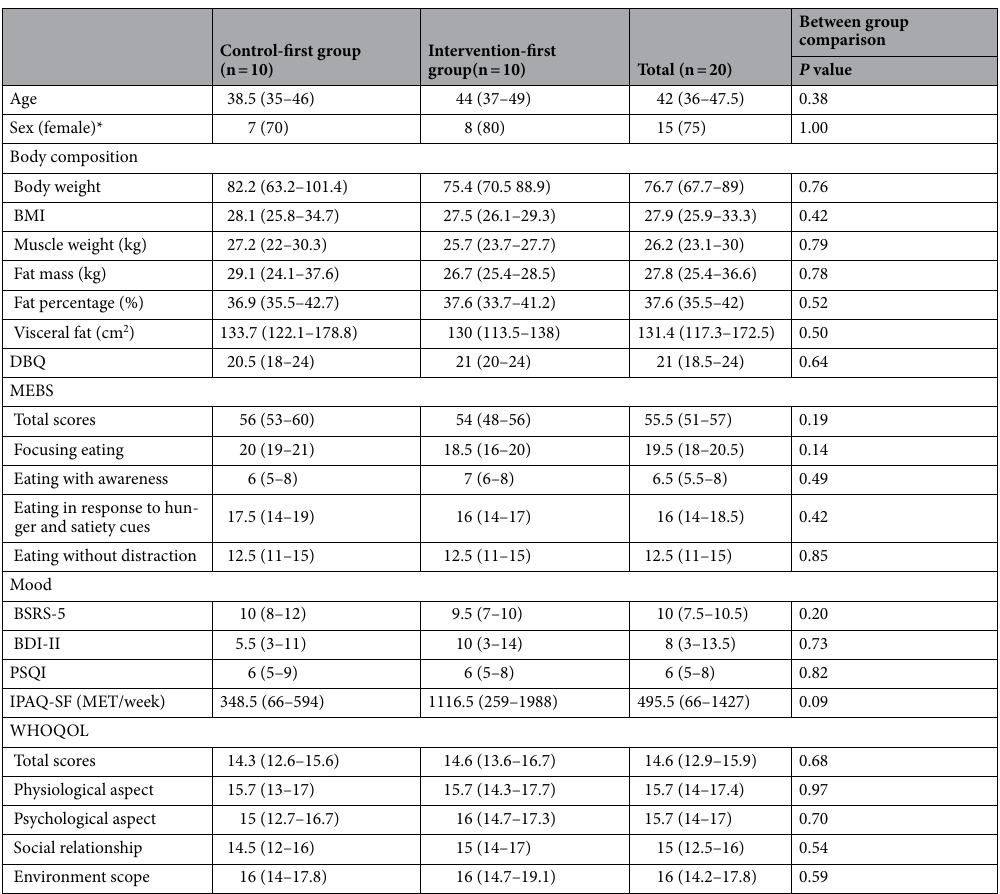
Table 1. Demographics and baseline characteristics of participants. Data were presented as median (interquartile range) or count (percentage)*. DBQ Dietary Behavior Questionnaire; MEBS Mindful Eating Behavior Scale; BSRS-5, five-item Brief Symptoms Rating Scale; BDI-II Beck Depression Inventory II; PSQI Pittsburgh Sleep Quality Index; IPAQ-SF International Physical Activity Questionnaire Short Form; MET metabolic equivalent; WHOQOL WHO quality of